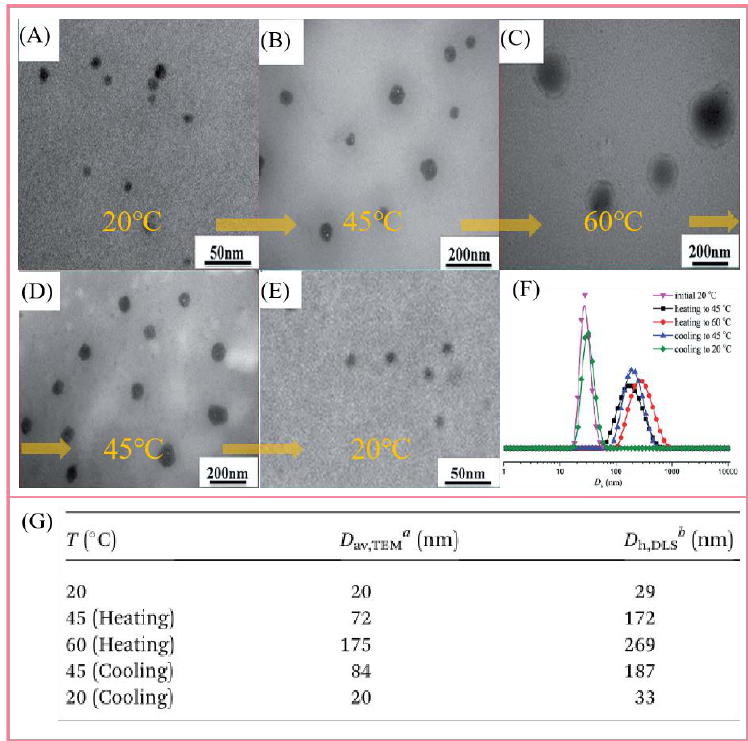
Figure 7. Typical TEM images of PNIPAM-(2CD-2MPEG) aqueous solutions ( A – E ) with a concen- tration of 1.0 mg·mL − 1 during the heating – cooling process. ( F – G ) The DLS results show a self-as- tion of 1.0 mg · mL − 1 during the heating–cooling process. ( F – G ) The DLS results show a self-assembly sembly process similar to that of TEM [138]. process similar to that of TEM